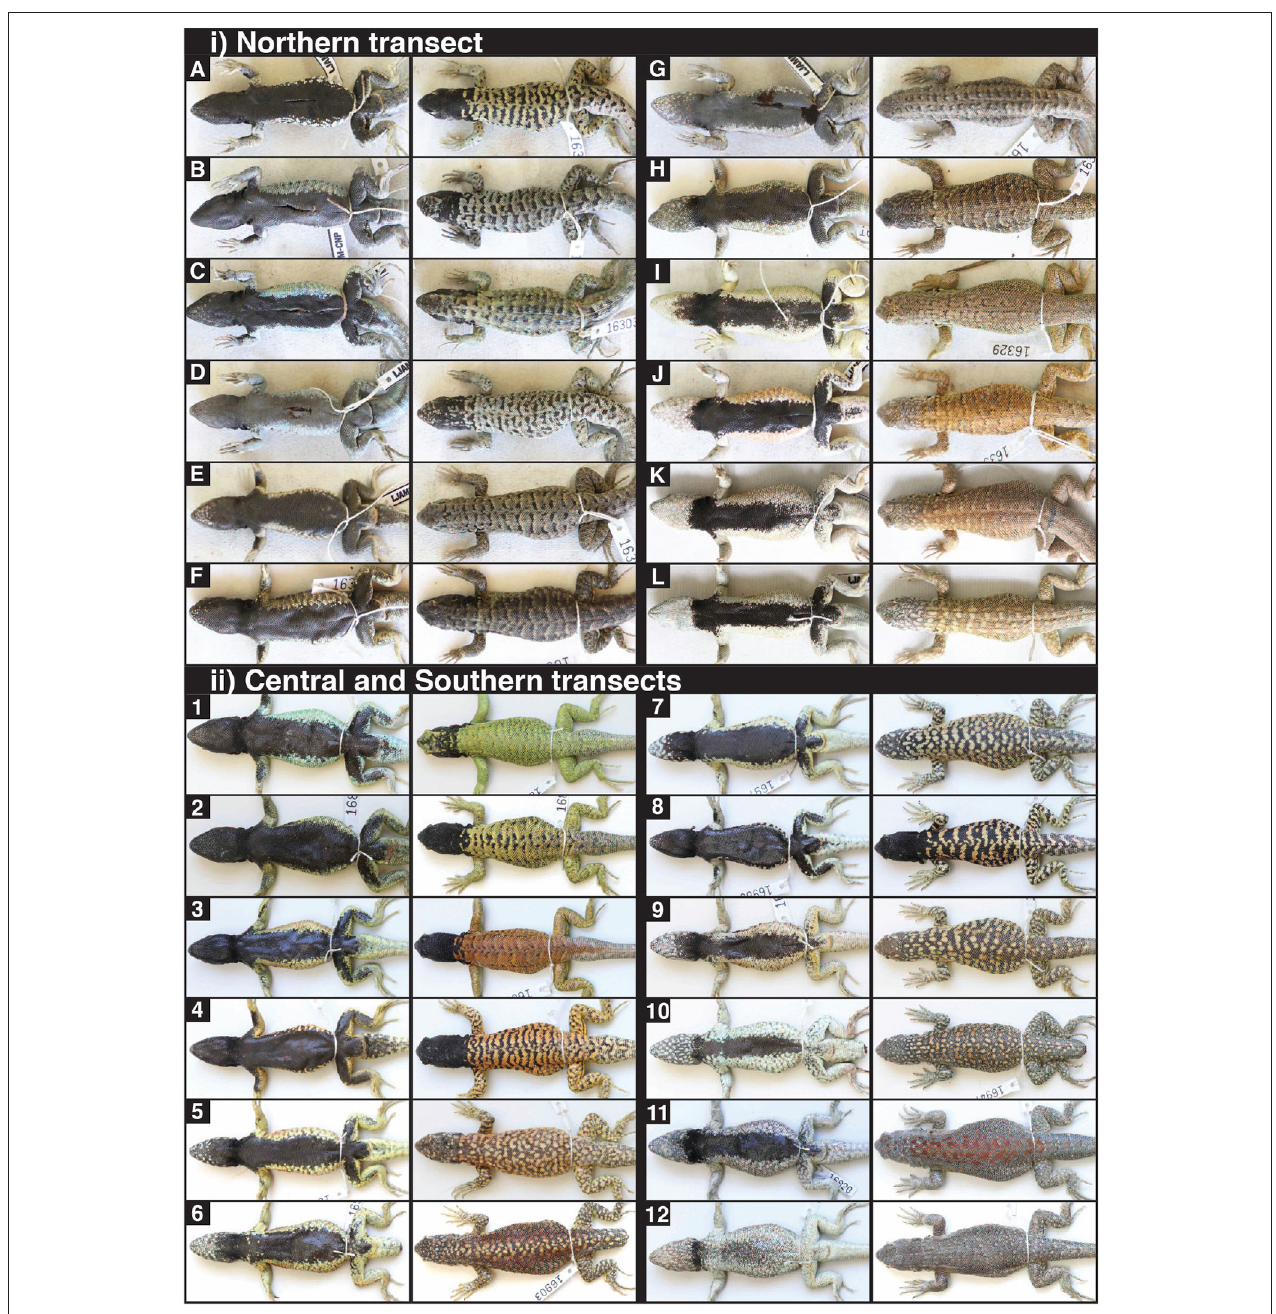
FIGURE 2 | Ventral and dorsal photos of males from localities sampled in the Northern (i) and Central + Southern (ii) hybrid zones. Letters and numbers indicate transect sampling points in Figure 4 . Photos were not available for individuals from localities M–P in the northern transect. maximum number of alleles of 32, 28, and 28 for